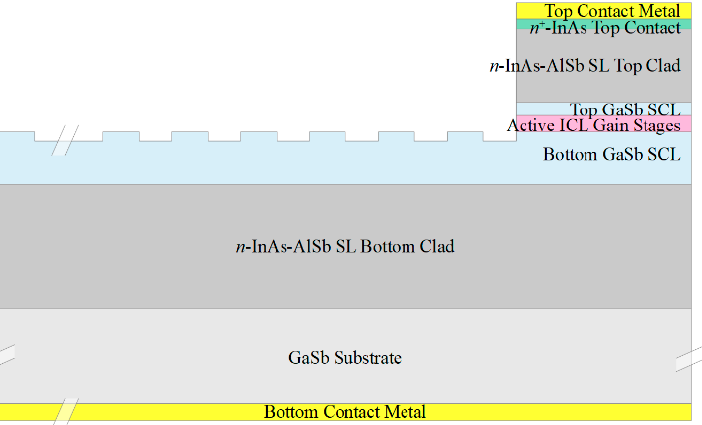
Figure 3. Schematic of a third-order distributed Bragg reflector (DBR) mirror that defines one end of an ICL cavity. If the DBR is designed for outcoupling the laser light, the mirror couples into a passive waveguide positioned farther to the left in the figure.